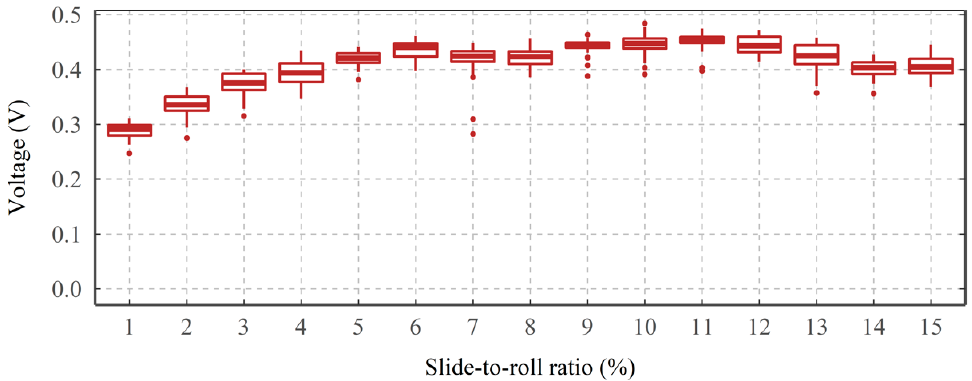
Figure 6. The average VADC for a variety of slide-to-roll ratios.